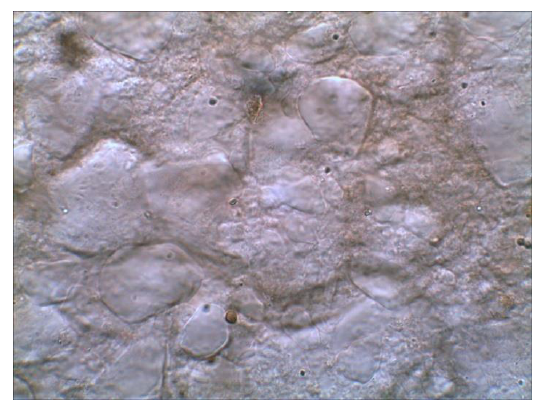
Рис. 3. Дисперсність гелю, що приготований при температурі 20 o C і 1500 об/хв., збільшення ×